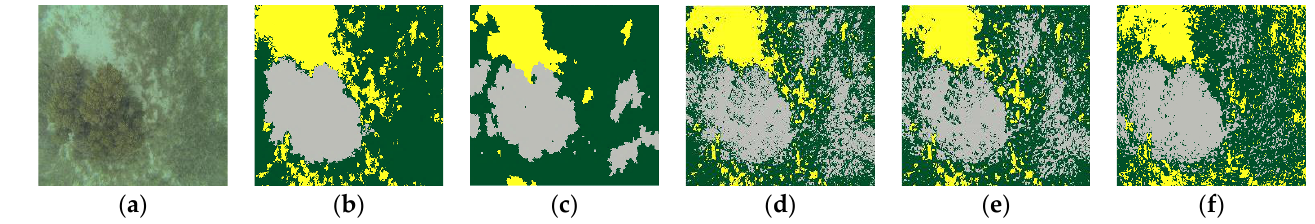
and yellow: sediments.